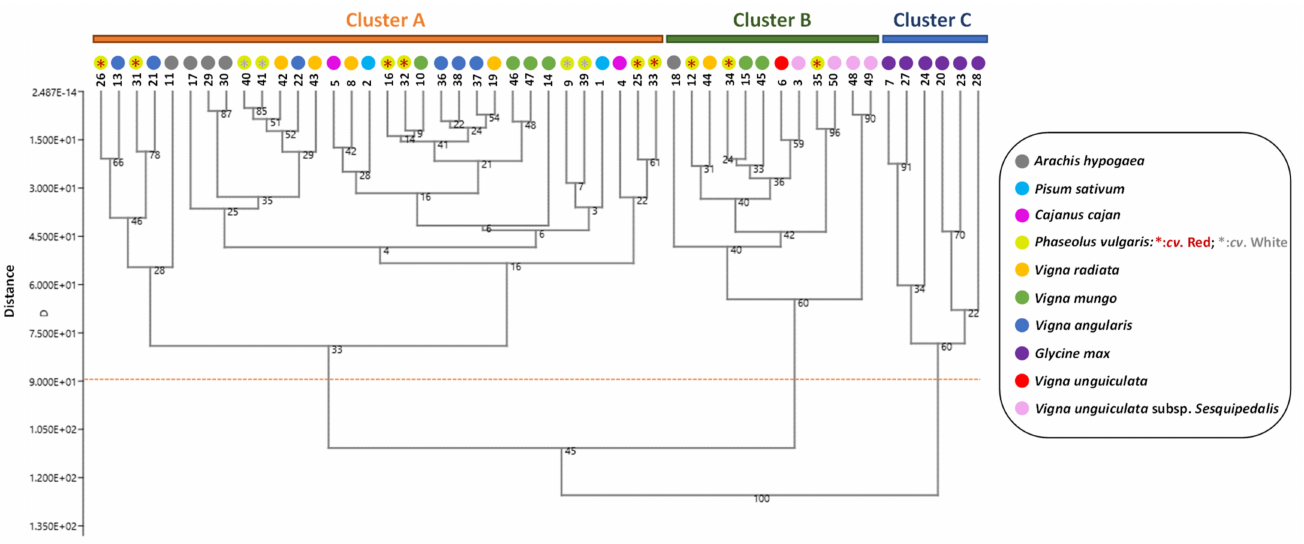
Figure 3. Hierarchical clustering analysis dendrogram according to the phytochemical composition of the extracts of 50 Fabaceae populations from various floristic regions from Thailand. The percentages of replicate trees in which associated samples cluster together in the bootstrap test (percentage of 5000 replicates) are shown next to the